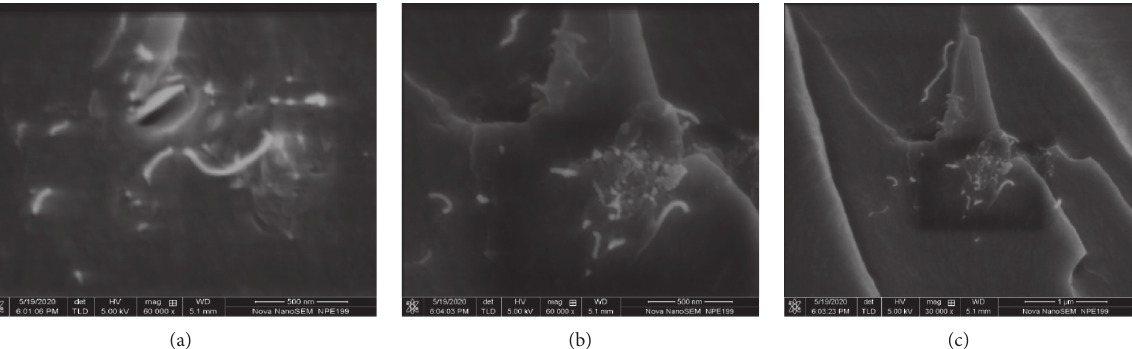
Figure 9: Structural morphology of the nanocomposite coating. (a) F3(1 % wt.% MWCNTs, 10 wt.%FA). (b) F2 (1 wt.% MWCNTs, 10 wt.%